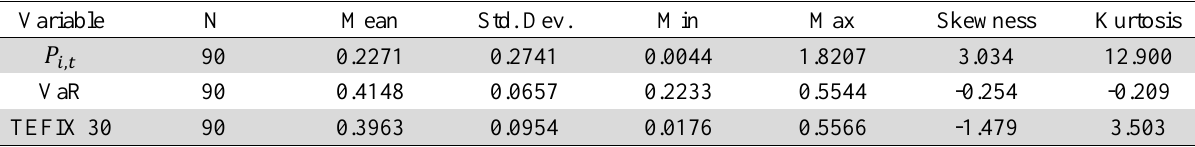
The summary of some basic